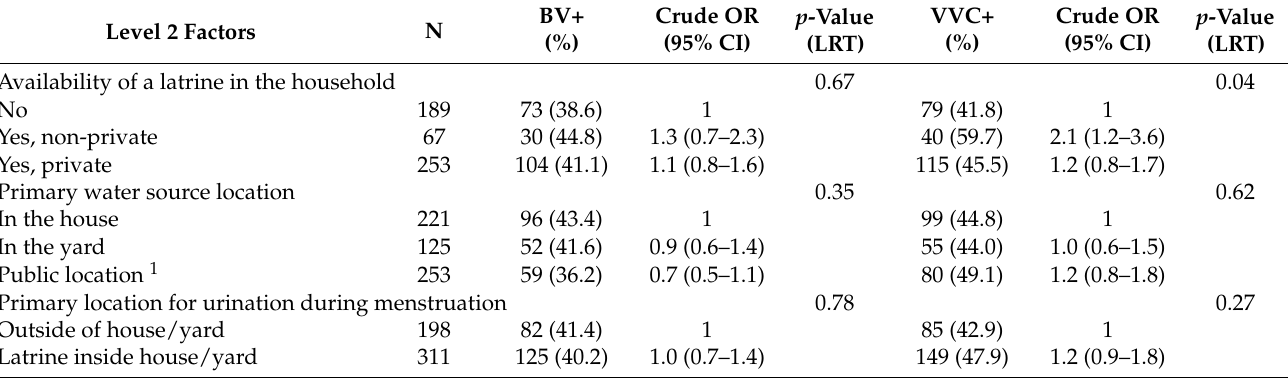
Table 2. Odds ratios for BV and VVC according to WASH factors (N =